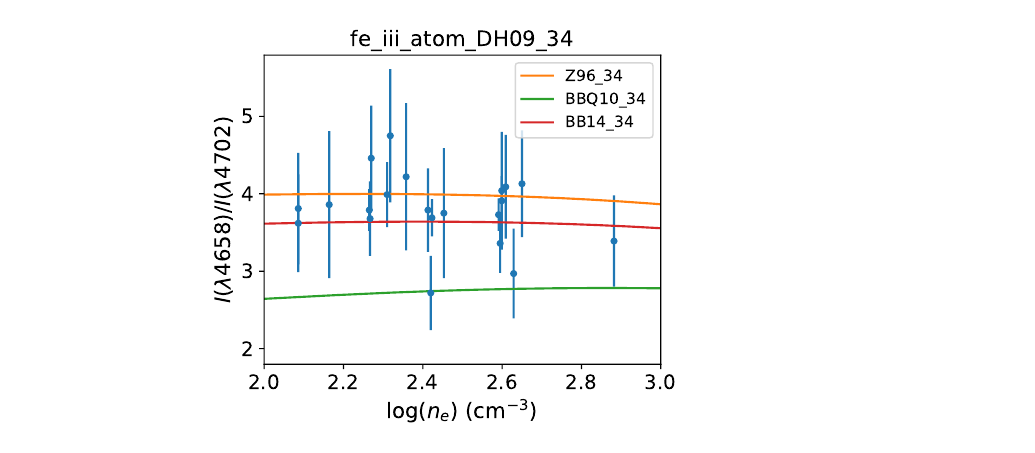
Figure 2. Observed [Fe III ] I ( λ 4658 ) / I ( λ 4702 ) line-intensity ratio from several low-density sources as a function of the [S II ] density. The theoretical emissivity ratios determined by PyNeb with dataset